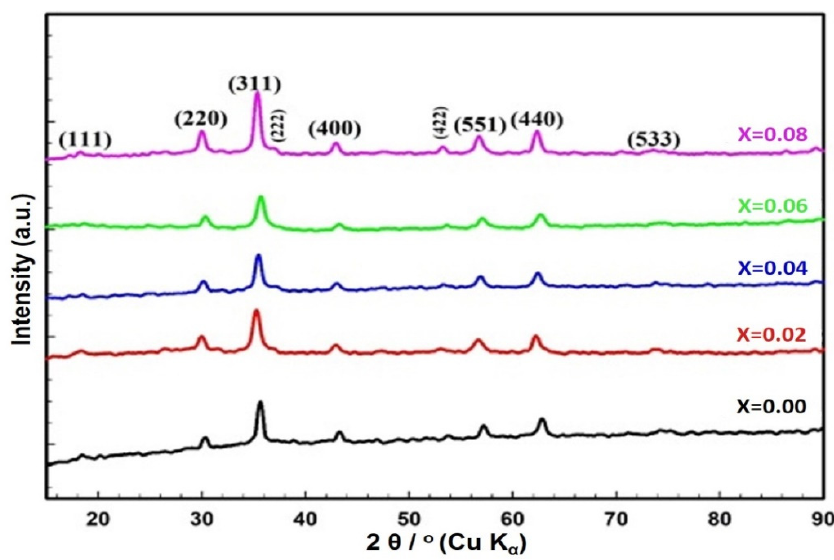
Figure 1. XRD patterns of ZnCe x Fe 2 − x O 4 (X = 0.0, 0.02, 0.04, 0.06, 0.08) NPs.